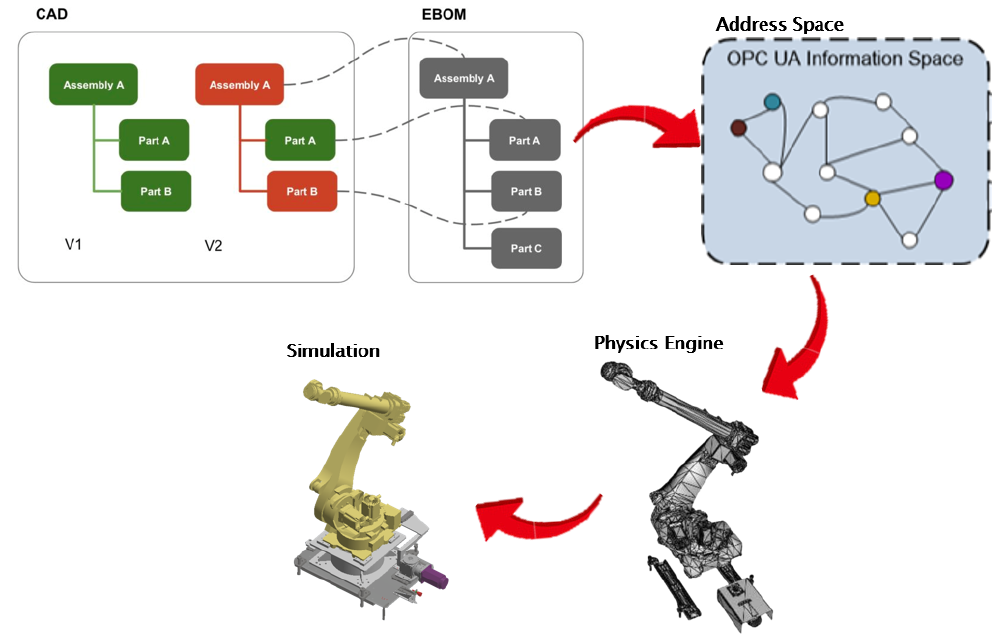
Figure 6. Simulation of CPS interworking.